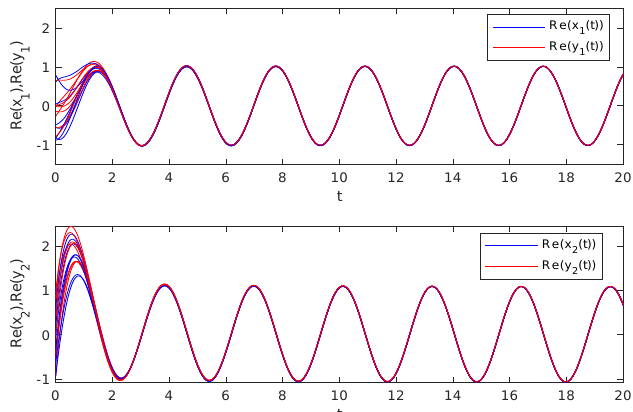
Figure 3. Dynamic evolution of the real part of the FCINN (26) with I 1 ( t ) = 5sin ( 2 t ) + i 5sin ( 2 t ) and I 2 ( t ) = 5cos ( 2 t ) + 5 i cos ( 2 t )